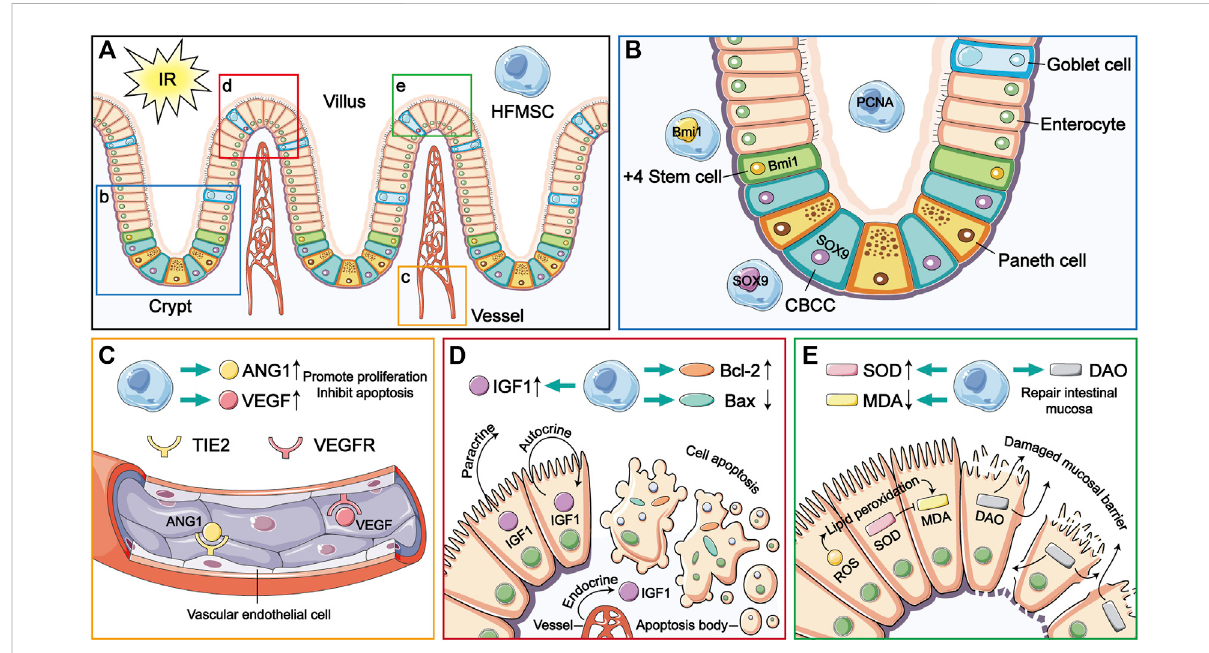
FIGURE 7 The therapeutic mechanism of HFMSCs in small intestinal IR injury. (A) HFMSCs home to thesite damaged by IR in the small intestine. (B – E) are magni fi edversionsofviewsb-ein (A) . (B) HFMSCsproliferatedinthesmallintestineandexpressedISCmarkers. (C) HFMSCsincreasedtheexpression levels of ANG1 and VEGF in small intestinal tissues, promoting angiogenesis. TIE2 and VEGFR are receptors of ANG1 and VEGF, respectively. (D) HFMSCs increased the expression levels of IGF1 and Bcl-2 in the small intestine, reduced the expression levels of Bax, promoted proliferation and inhibited apoptosis. (E) HFMSCs reduced the MDA content and increased the SOD content, regulating oxidative stress levels in the IR damaged small intestine. HFMSCs increased the DAO content in the small intestine and protected mucosal barrier